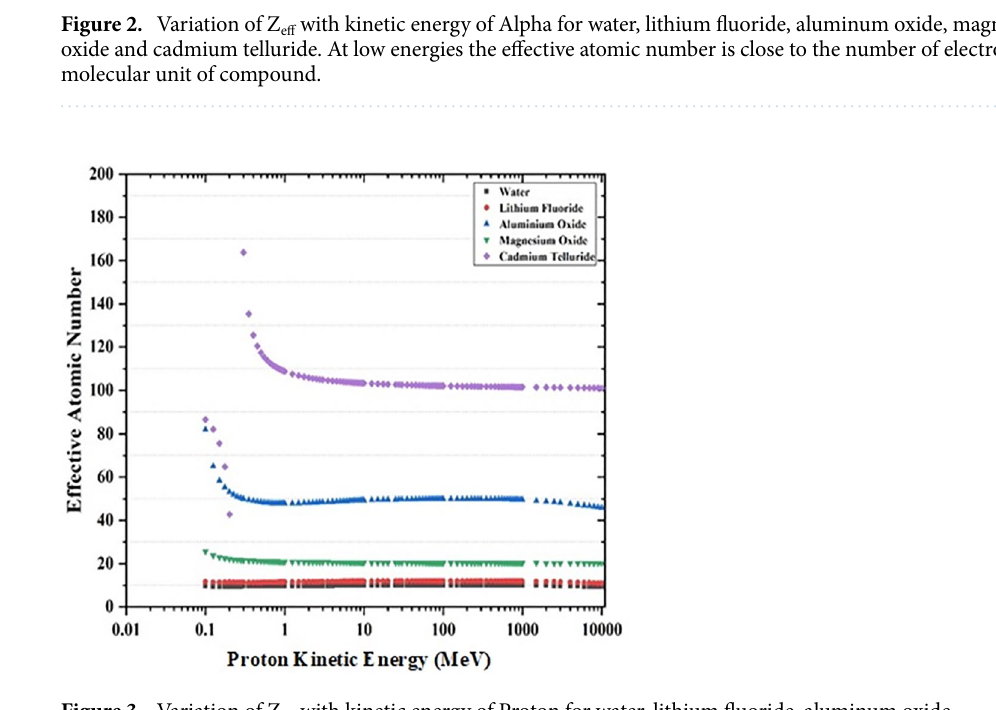
Figure 3. Variation of Z eff with kinetic energy of Proton for water, lithium fluoride, aluminum oxide, magnesium oxide and cadmium telluride. At low energies the effective atomic number is close to the number of electrons in molecular unit of